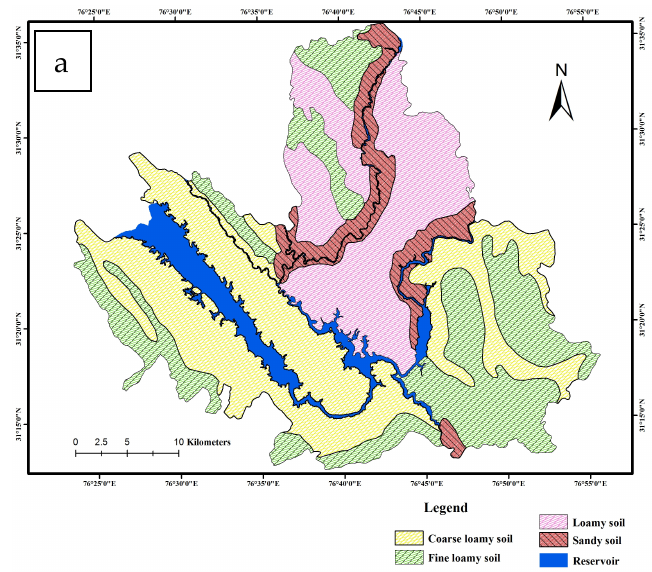
Figure 10. Cont b